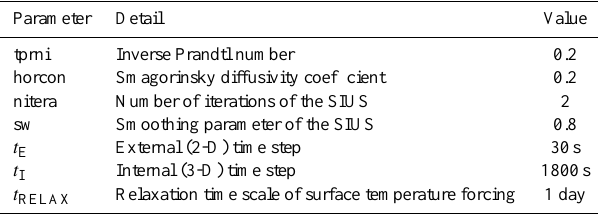
Table 1. Overview of parameter values used to set up the model. SIUS: Smolarkiewicz iterative upstream